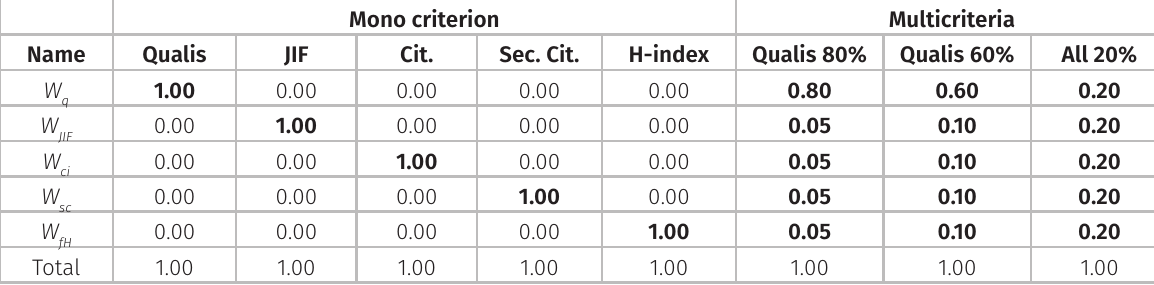
Table IV. Weights for classifying productivity for mono criteria and multicriteria